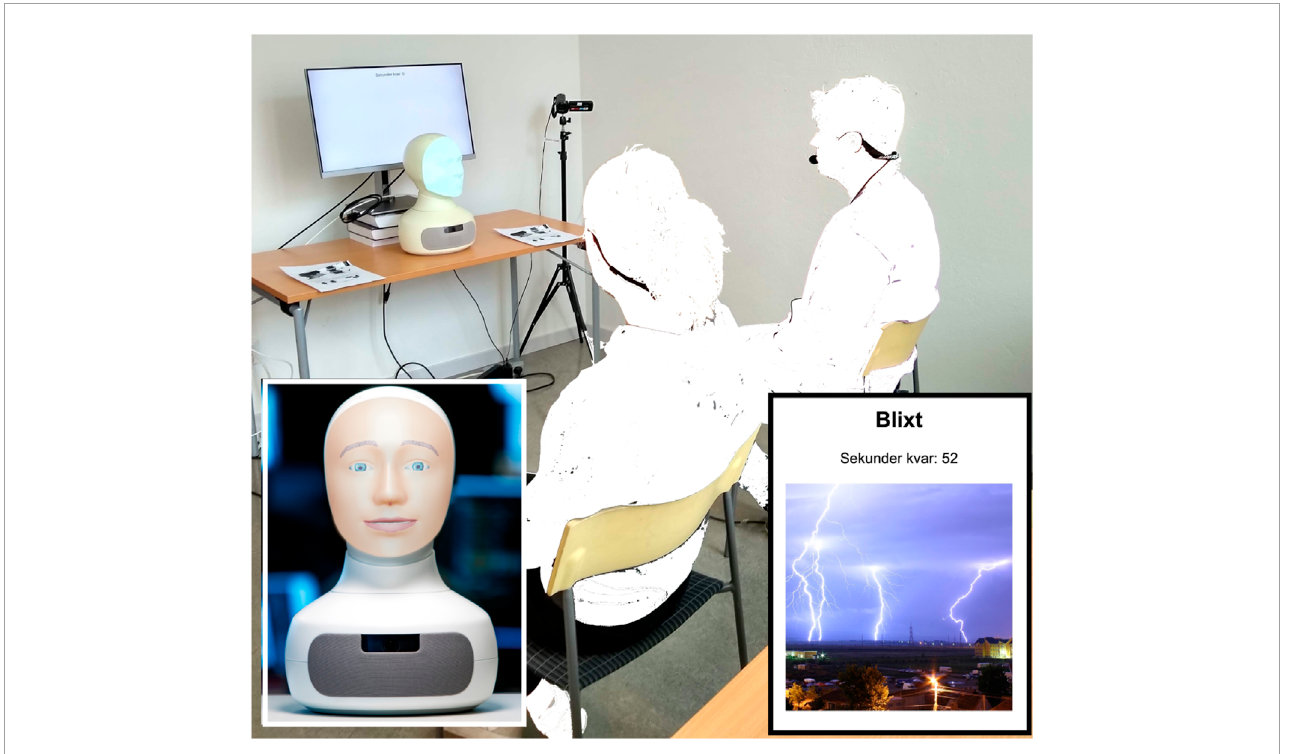
FIGURE 1 Experiment set-up showing the placement of the robot, the word game screen, anonymized participants and the front camera. Inlay, left: The Furhat robot. Inlay, right: Game card showing word, picture and number of seconds